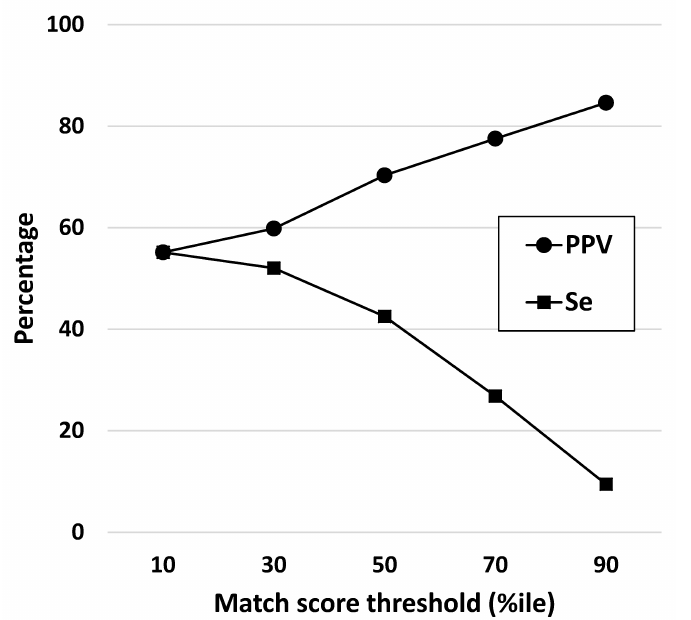
Figure 3: Sensitivity (Se) and positive predictive value (PPV) of automated retrospective record linkage at various match score percentile thresholds, full